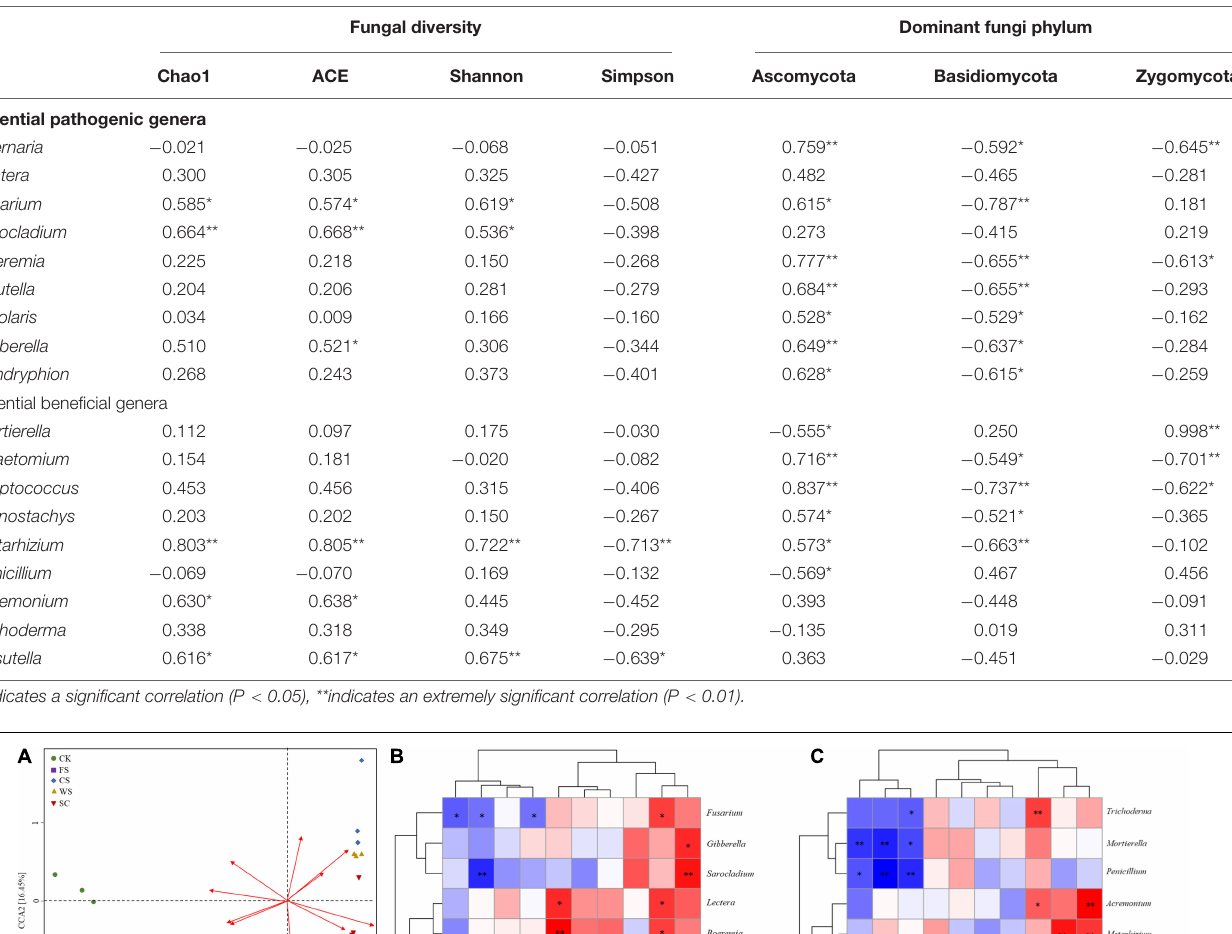
TABLE 1 | Correlations between potential pathogenic genera, potentially beneficial genera and the fungal community.